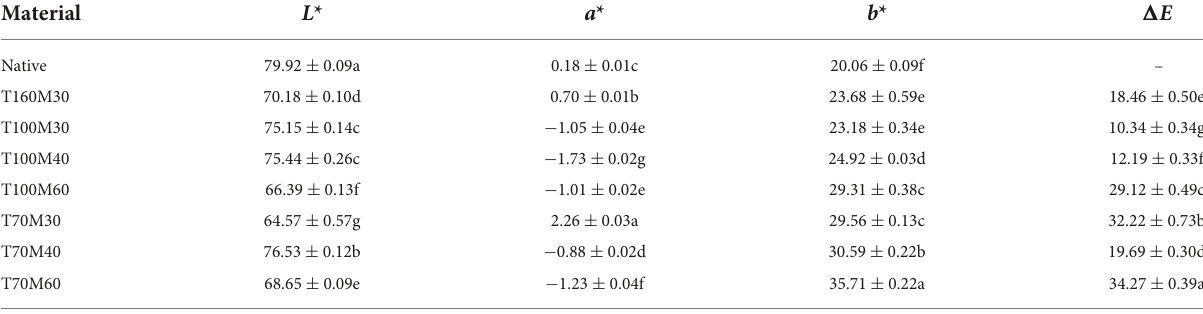
TABLE 3 The color properties of the native and pregelatinized Tartary buckwheat flour. Material